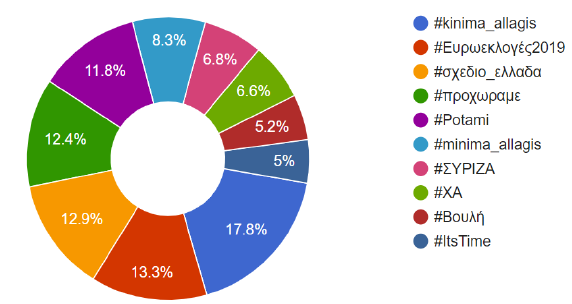
Figure 8. The 10 most popular hashtags for all political leaders.